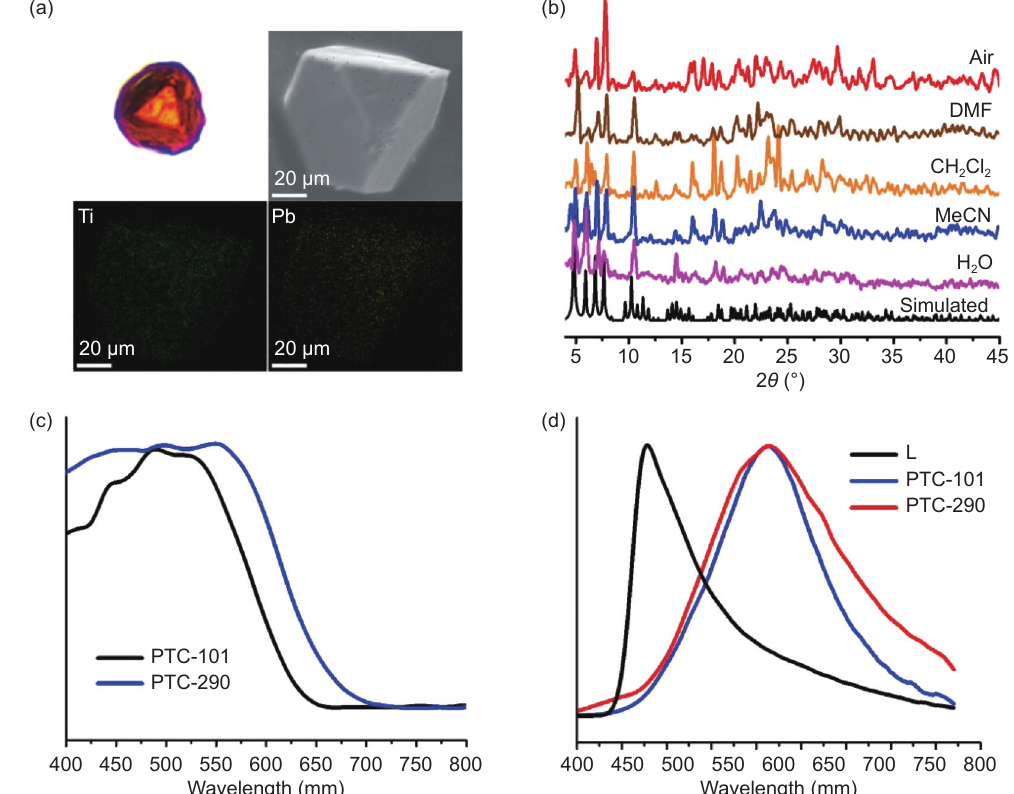
Figure 2 (a) Photo of crystal and SEM mapping spectra of PTC-290. (b) PXRD patterns of simulated PTC-290 and crystals of PTC-290 immersed in H 2 O, MeCN, CH 2 Cl 2 , DMF for 1 day, as well as exposed in air for 1 day. (c) Solid-state UV/vis absorption spectra of PTC-101 and PTC-290. (d) Emission spectra of L ligand, PTC-101, and PTC-290 in the solid state at room